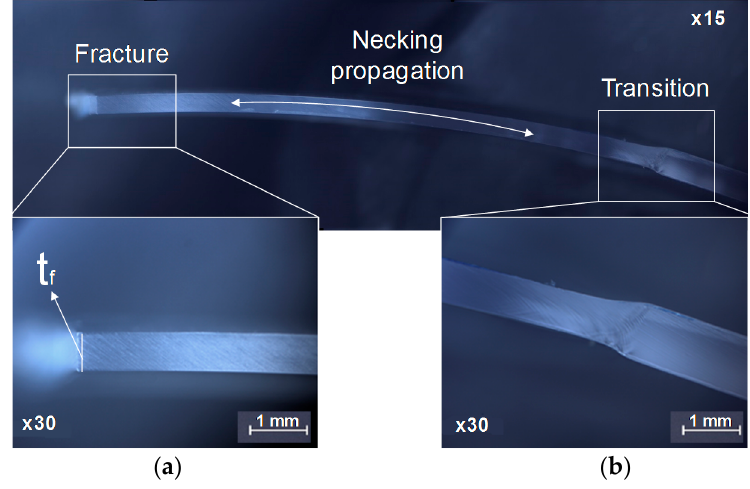
Figure 8. Fractography of a PT Nakajima specimen with 1 mm of thickness. Magnification of: ( a ) The fracture zone and ( b ) the transition zone.